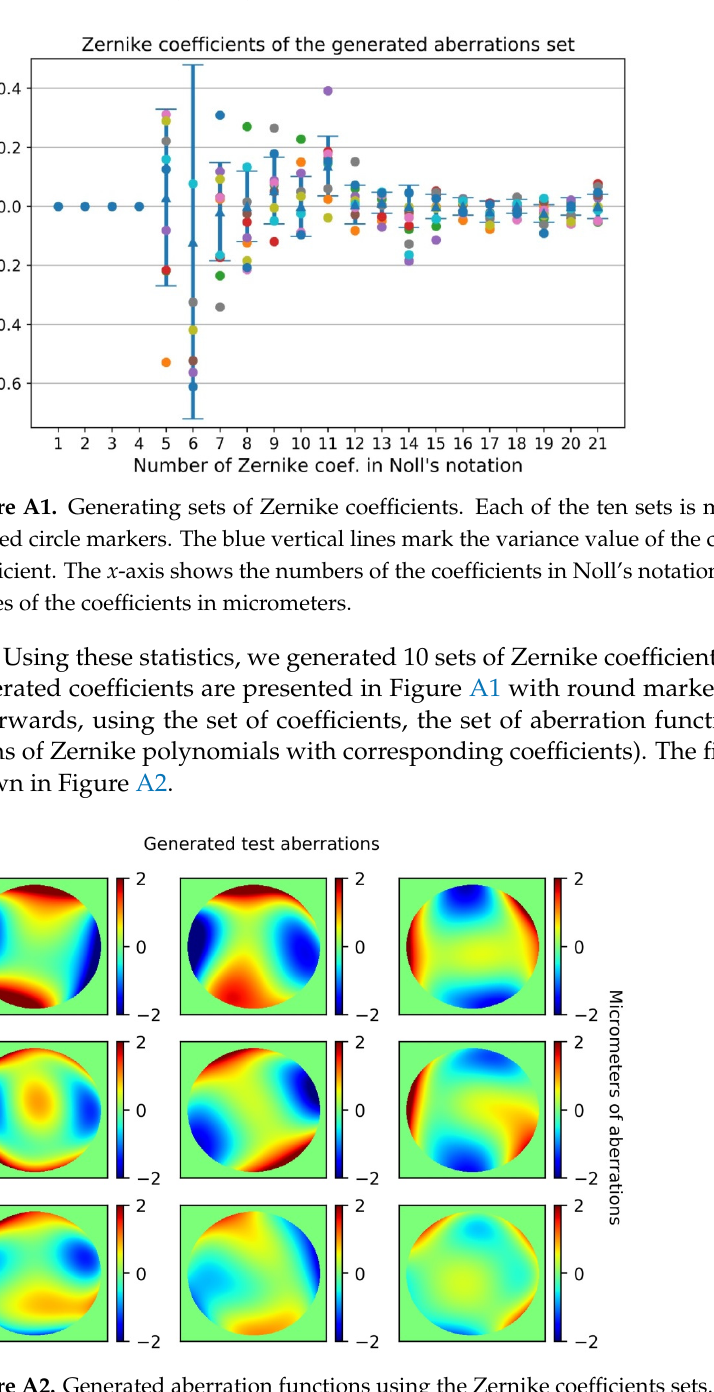
Figure A2. Generated aberration functions using the Zernike coefficients sets. The first nine individual functions.